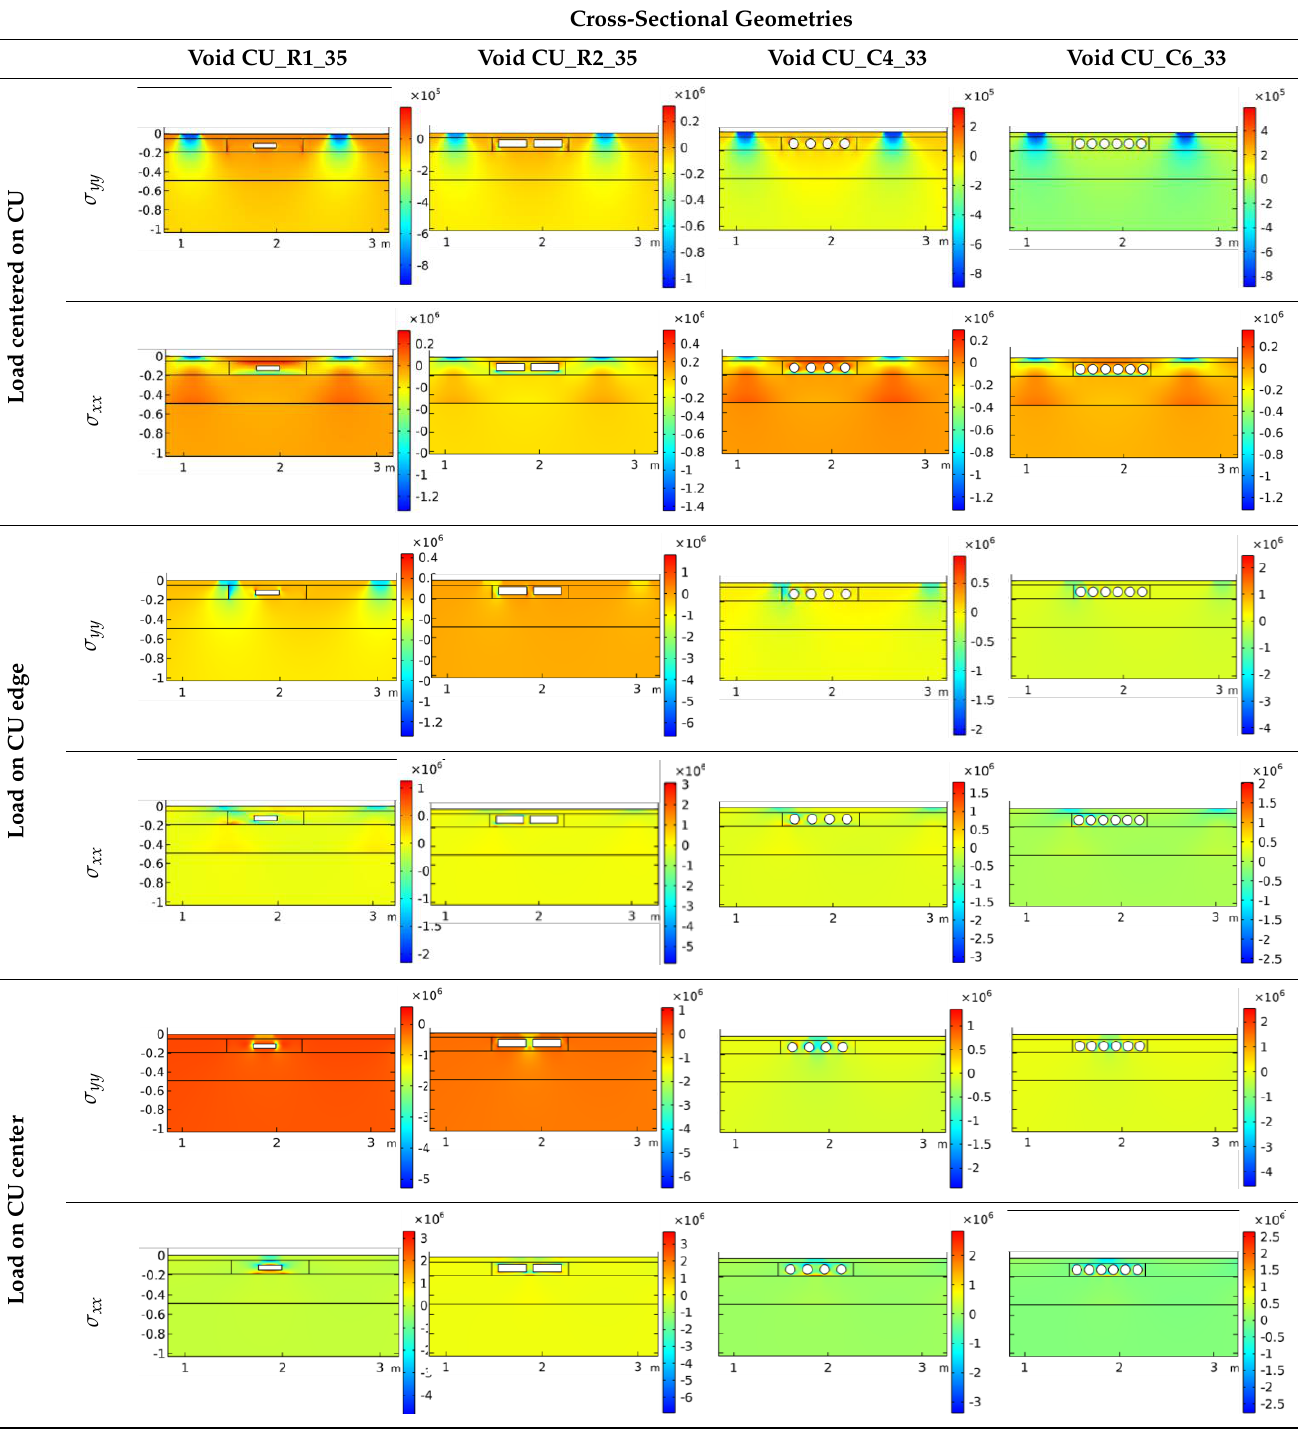
Table 3. Distribution of vertical/horizontal stresses σ yy /σ xx [N/m 2 ] at different cross-sectional geometries of e-road and different load positions.